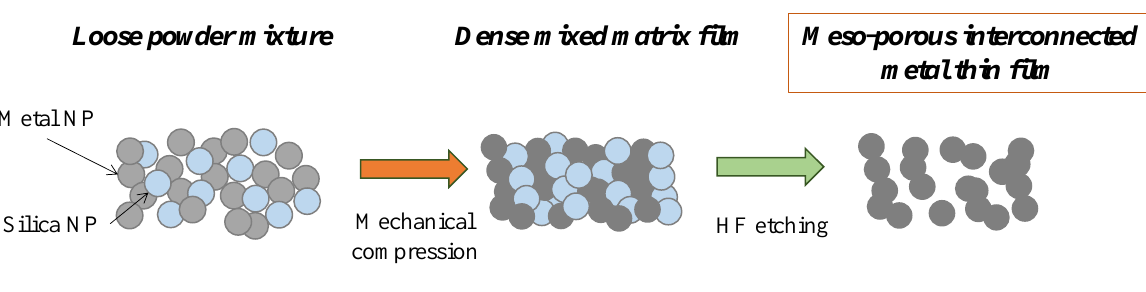
Figure 1. Schematic of the powder mixing, cold-compression and silica etching process leading to a meso-porous pure metal